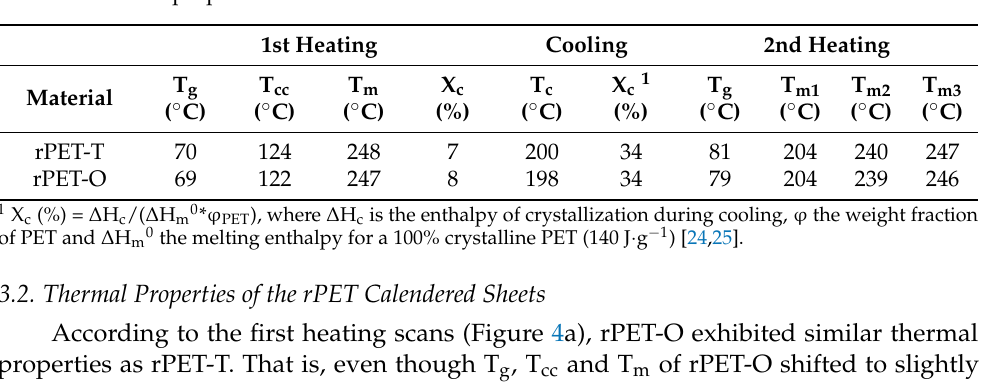
Table 3. Thermal properties of the manufactured rPET